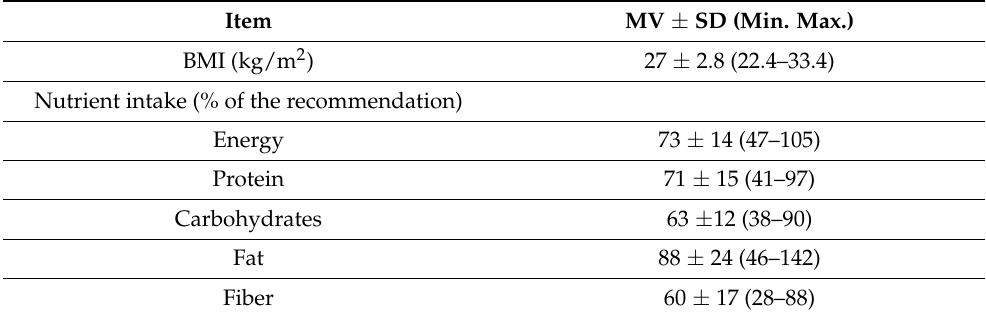
Table 3. BMI ( n = 24) and percentage of the actual in relation to the recommended energy and nutrient intake according to Arends et al. [14] of participants who completed the nutrition assessment ( n = 16) (MV ± SD (Min.